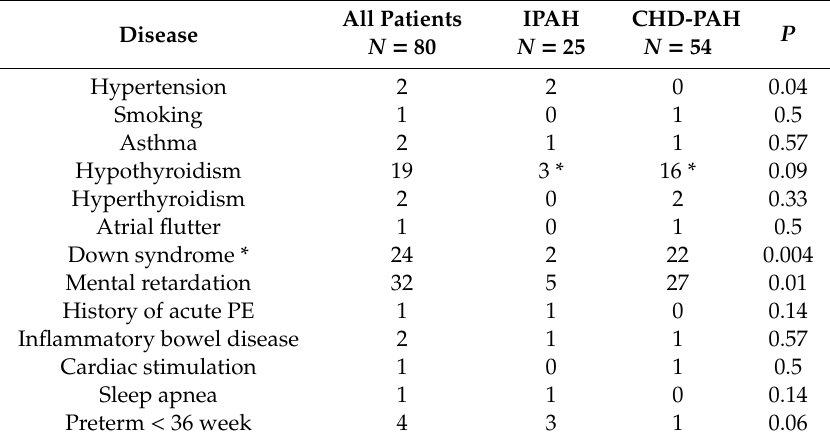
Table 2. Concomitant diseases in IPAH and CHD-PAH.